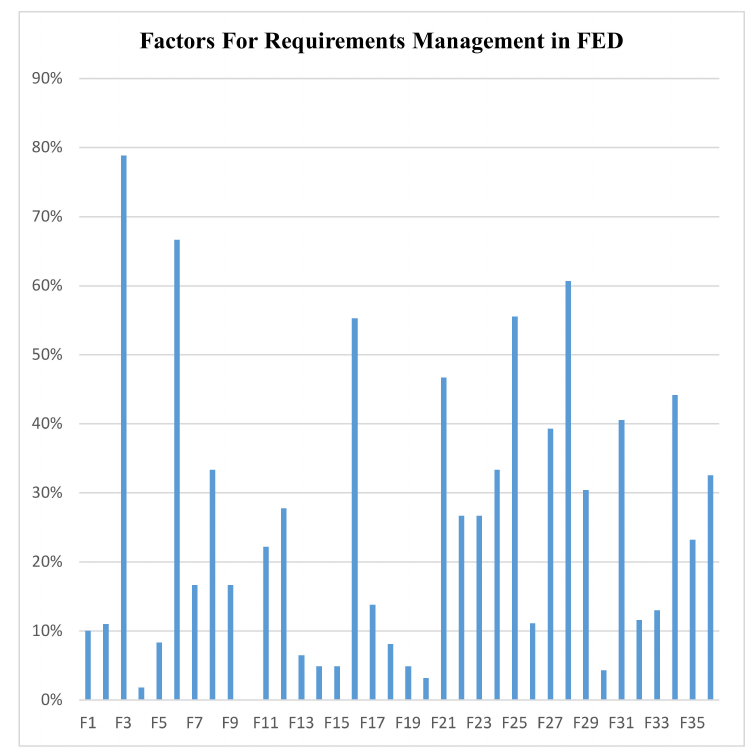
Figure 9. Requirements rankings in